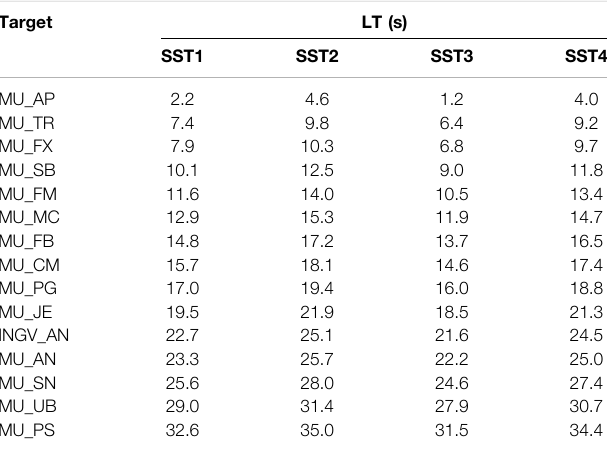
TABLE 6 | Results of LT for selected targets. Target: city code. Place: extended name of cities. LT: Values of LT in seconds referred to the test in Table 4 . Target LT (s) SST1 SST2 SST3 SST4